Question: What kind of plot is shown here?
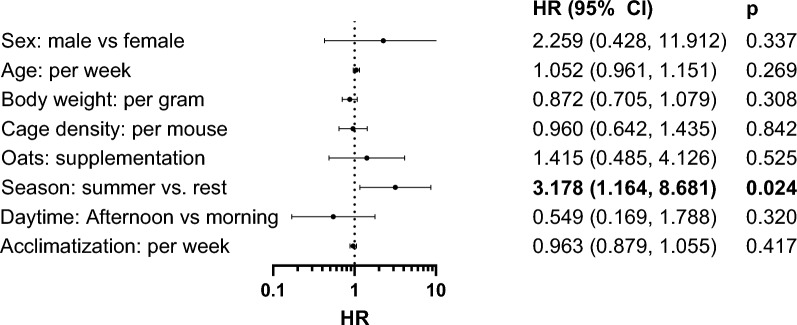
Answer: forest